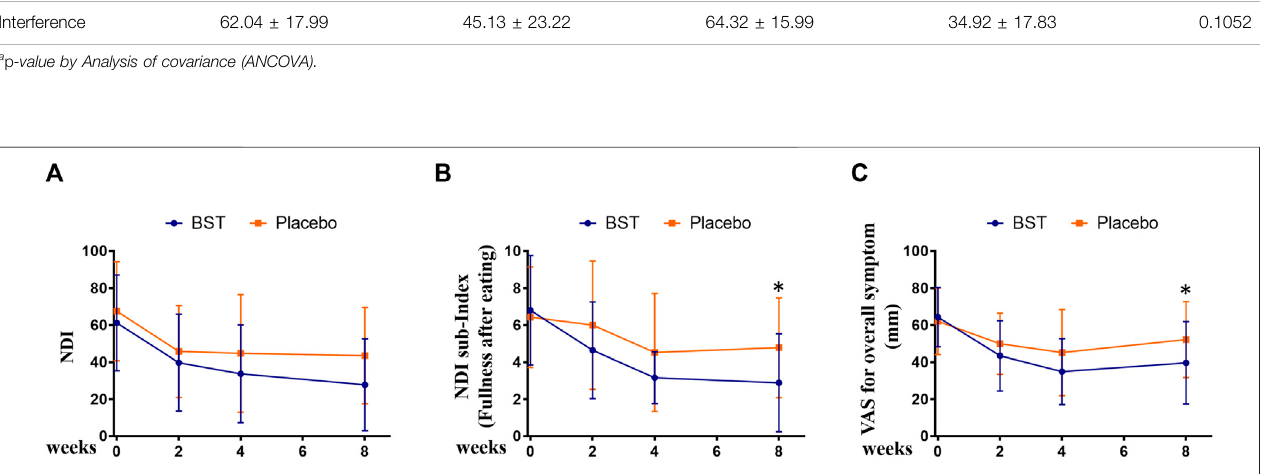
Frontiers in Pharmacology |